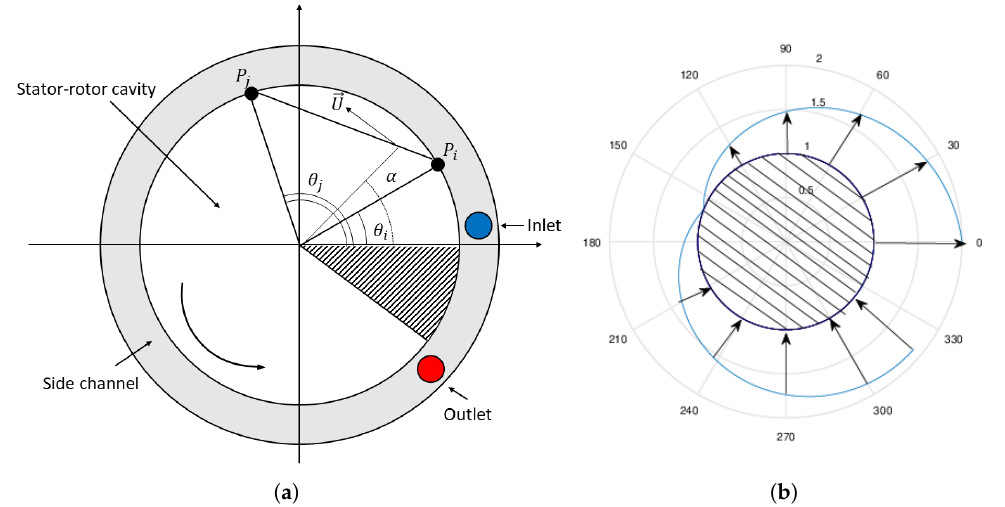
Figure 7. ( a ) Nomenclature for angular positions; and ( b ) tangential Q distribution